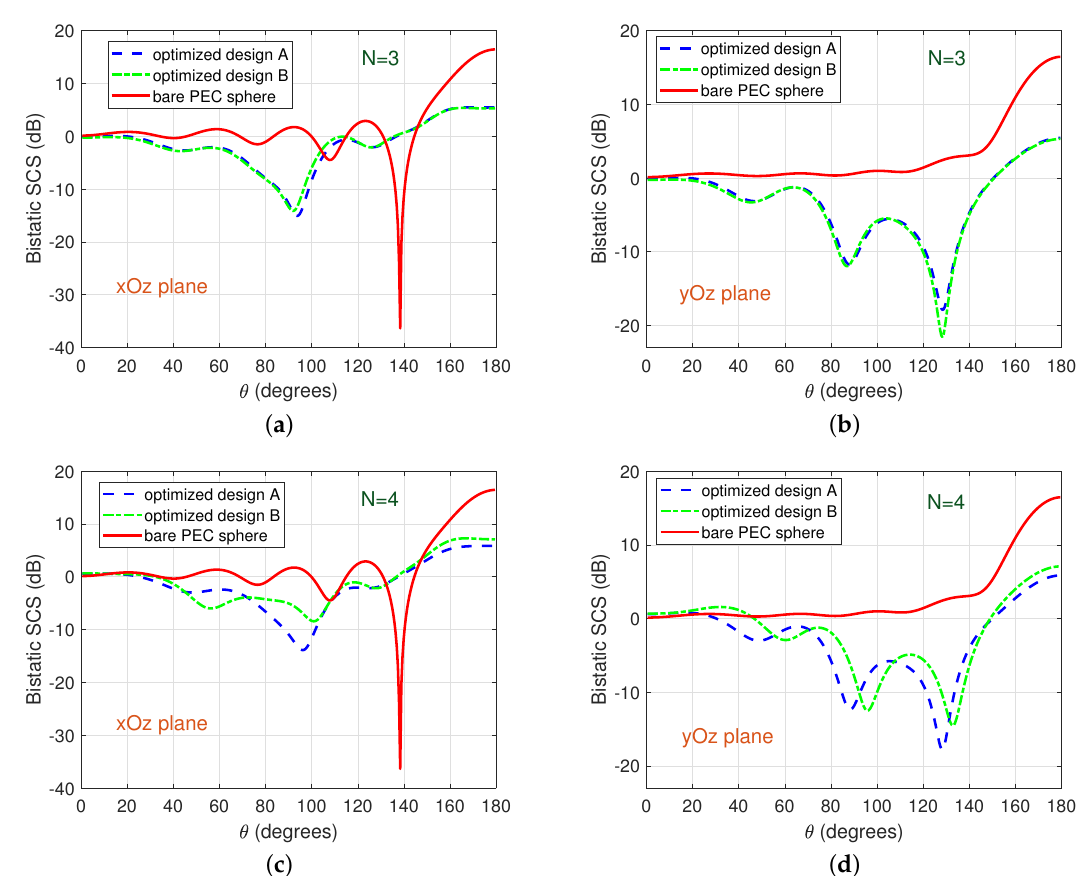
Figure 2. Normalized bistatic SCS σ ( θ , φ ) / ( π a 2 c ) in the xOz and yOz planes versus the angle θ for ( a , b ) N = 3 and ( c , d ) N = 4 optimized spherical layers covering a PEC core of radius k 0 a c = 2 π excited by a dipole at b = 10 a c (nearly plane-wave incidence case).